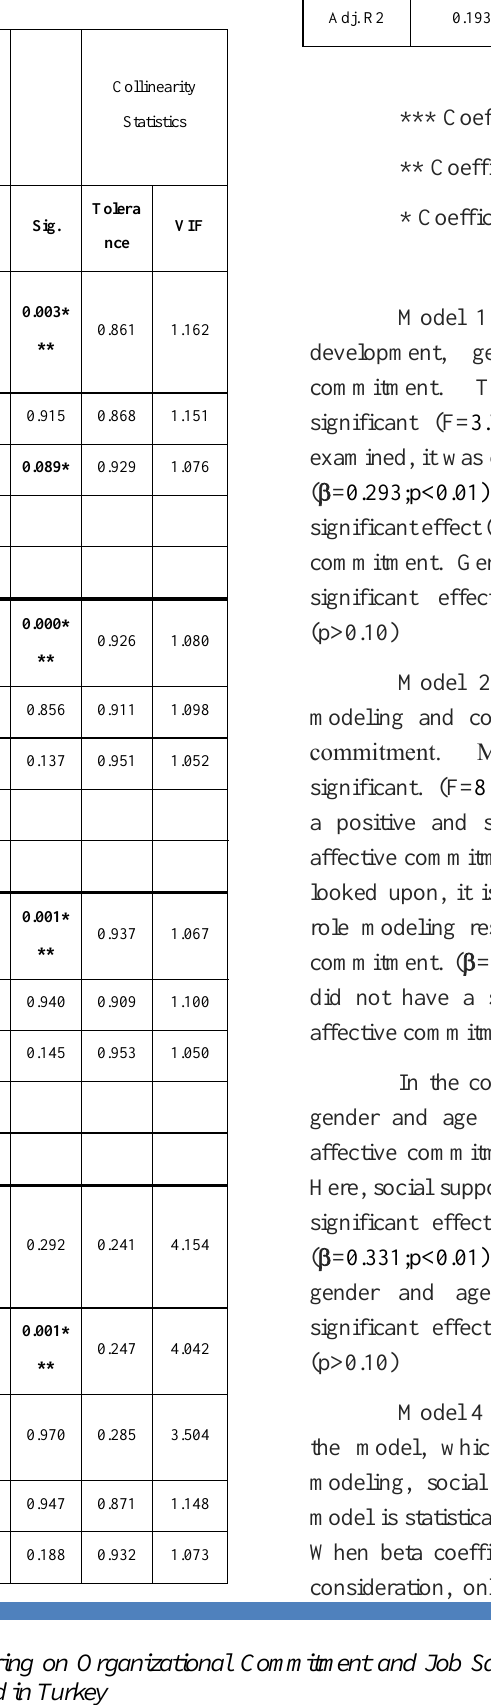
Table 6. The Effect of Mentoring on Affective